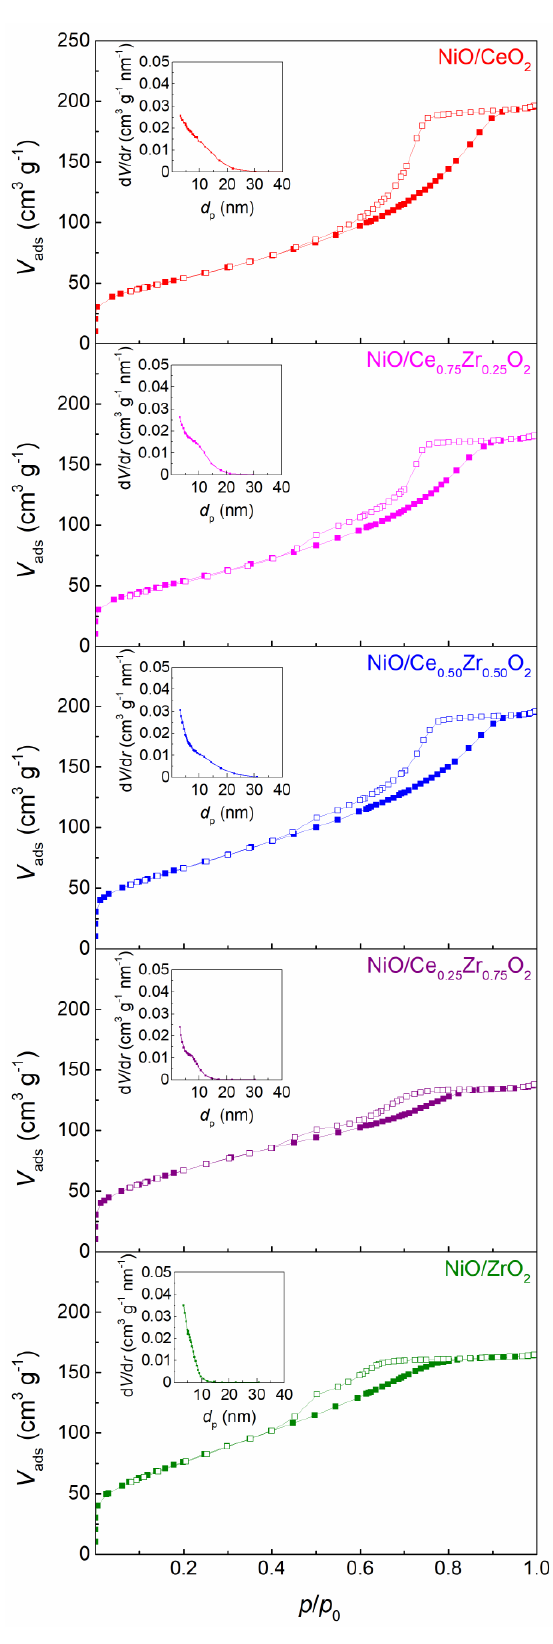
Figure 1. N 2 adsorption (full symbols) and desorption (open symbols) isotherms and pore size distribution curves (insets) of the NiO/Ce x Zr 1- x O 2 samples.